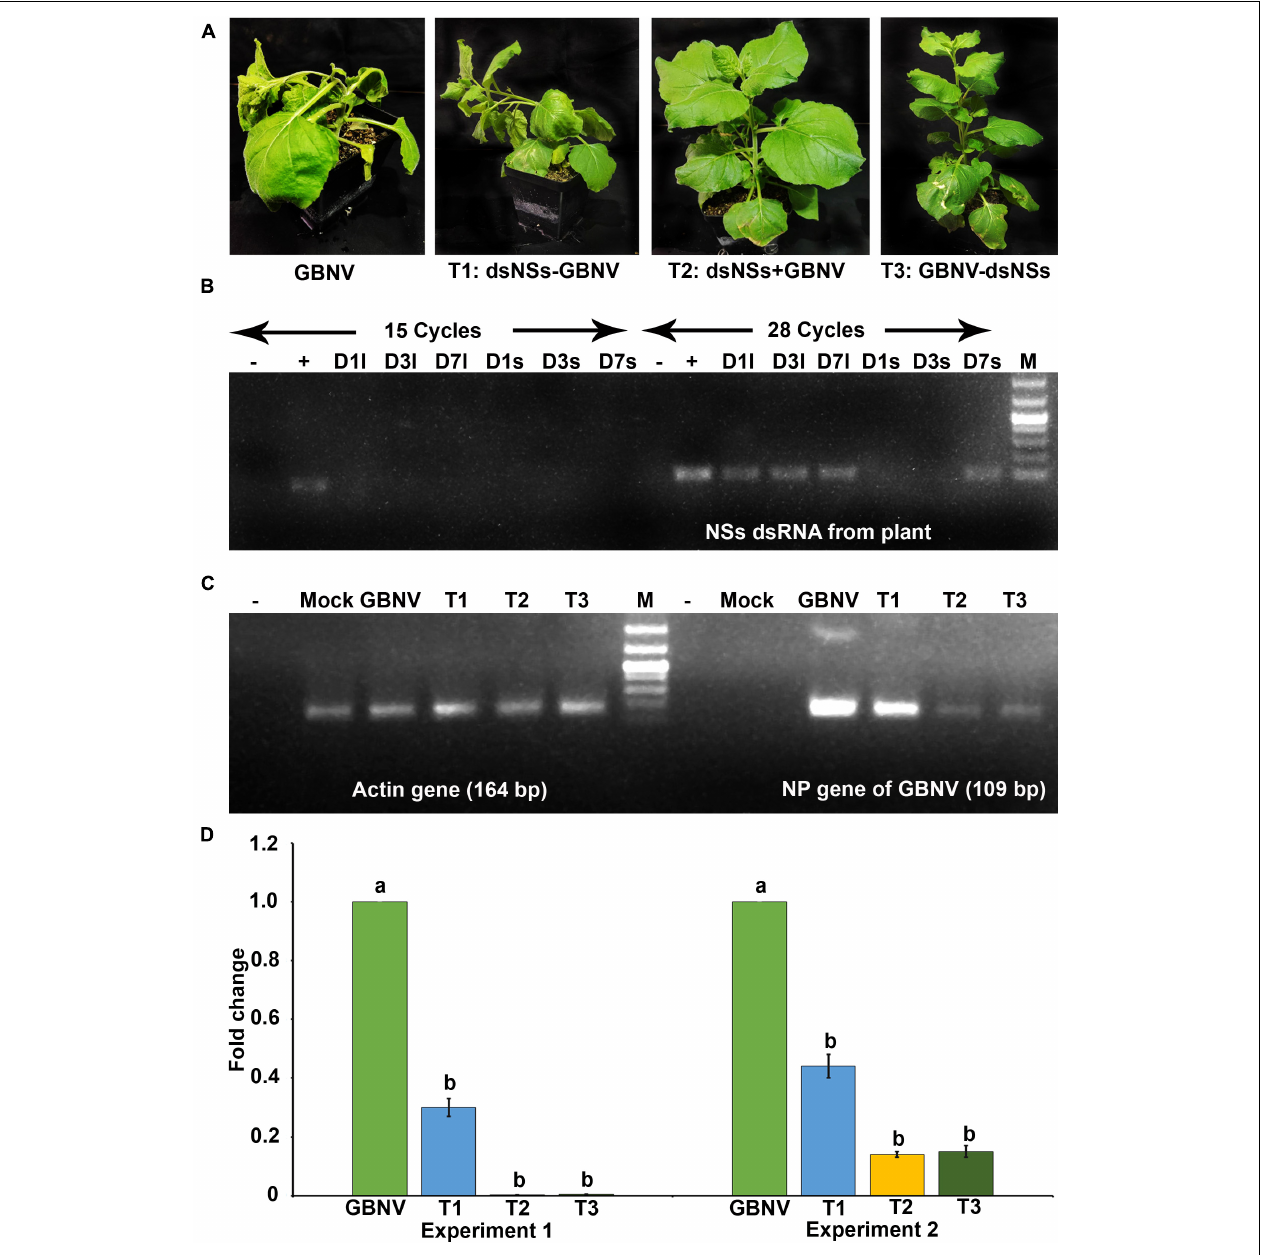
FIGURE 2 | Effect of topically applied dsNSs of GBNV in the Nicotiana benthamiana challenged with GBNV at 9 days post inoculation (dpi). (A) Treatment combinations: T2: dsNSs + GBNV (dsNSs treatment followed by virus inoculation) and T3: GBNV-dsNSs (dsNSs was applied a day post inoculation with GBNV) showed no necrosis and wilting while treatment combination T1: dsNSs – GBNV (dsNSs was applied a day before GBNV inoculation) as well as dsNSs untreated control plants exhibited those symptoms. (B) Stability analysis of dsNSs in the absence of GBNV in the local (l) and systemic (s) leaves during 1–7 dpi (D1–D7) by semiquantitative reverse transcriptase PCR (sqRT-PCR). (C) Detection of GBNV in the dsNSs-treated plant by sqRT-PCR of NP gene showing reduction of amplification of NP gene in different treatments compared to dsNSs untreated control plants. Actin was taken as internal control. (D) Quantitative reverse transcriptase PCR (qRT-PCR) showing significant reduction ( p ≤ 0.05) of GBNV titer in all the three treatment combinations. Different letters indicate statistically significant difference ( p ≤ 0.05). Two independent experiments were analyzed using Actin gene as endogenous reference control. –, reagent control; +, Plasmid of NSs clone (Positive control); Mock, buffer inoculated healthy plant; M, DNA mark 1 kb plus DNA ladder (G-Biosciences, United